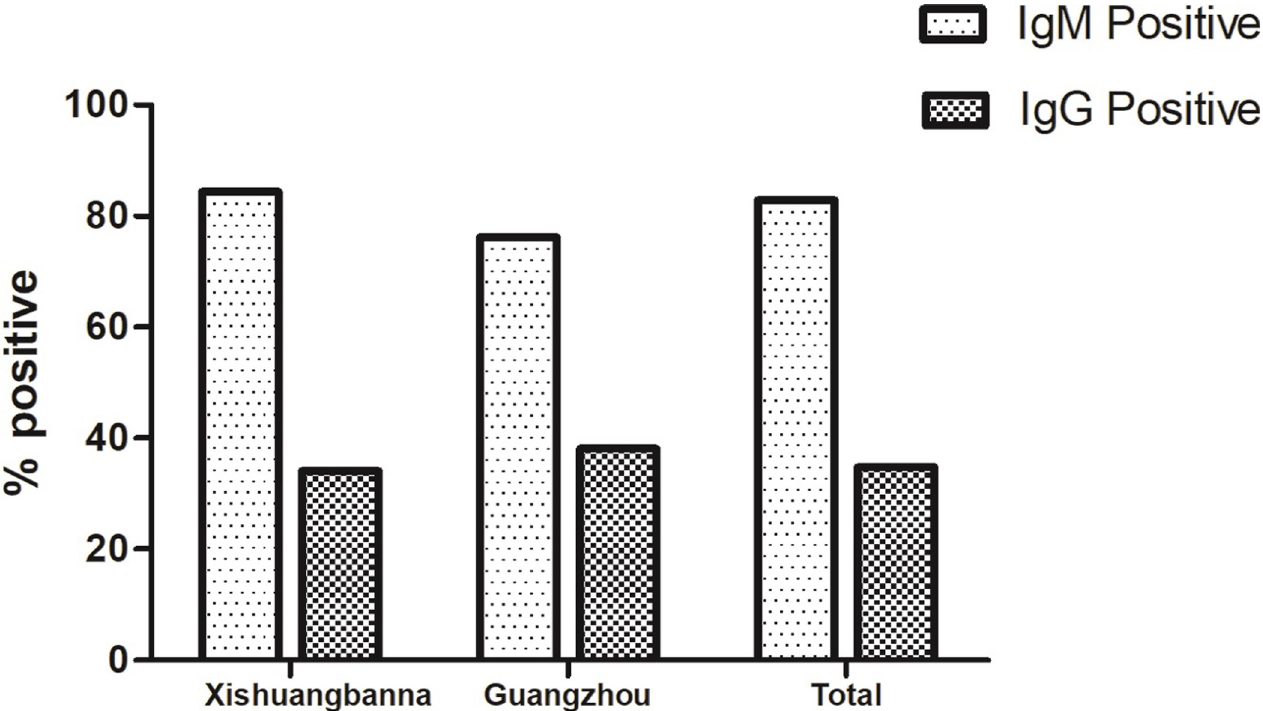
Fig 3. Seroprevalence of DENV-IgG and seroincidence of DENV-IgM antibodies in the patients from Guangzhou and Xishuangbanna of China.